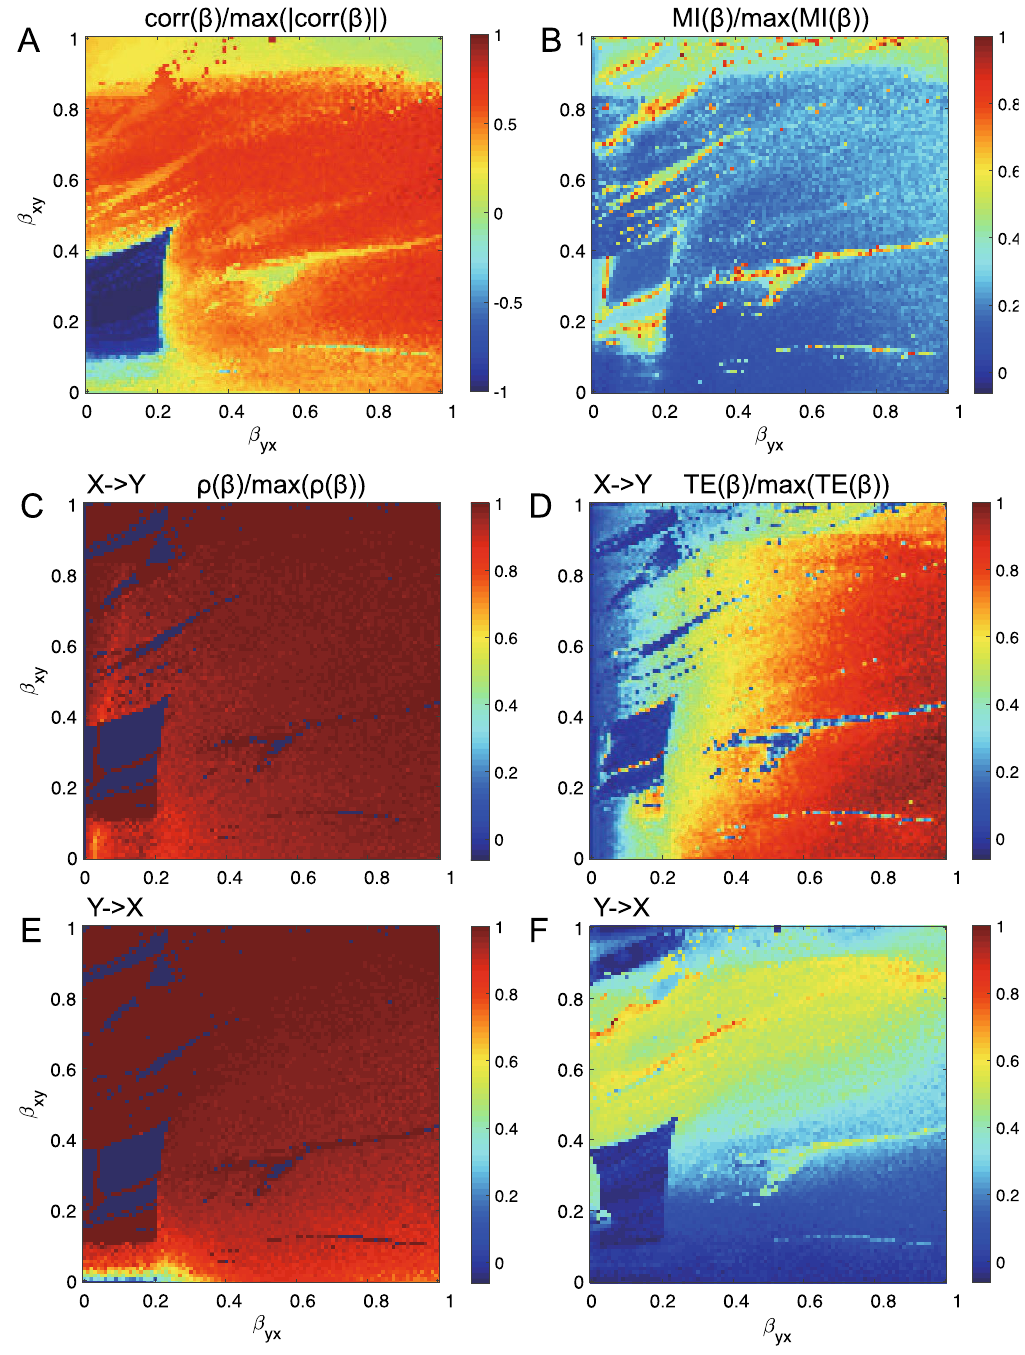
Figure 3. Phase-space maps of normalized coupling predictive causation via correlation, mutual information, CCM and OIF for varying true causal interactions. Both true causal interactions β xy and β yx are free varying within the range [0, 1], indicating a bivariate model S( β xy , β yx ) where both species (or variables more generally) are interacting with each other with different strength. ( A ) normalized correlation coefficient, ( B ) normalized mutual information, ( C ) and ( E ) normalized CCM correlation coefficient ( ρ ) for interaction directions of X → Y and Y → X , ( D ) and ( F ) normalized transfer entropy ( TE ) from OIF model for interaction directions of X → Y and Y → X